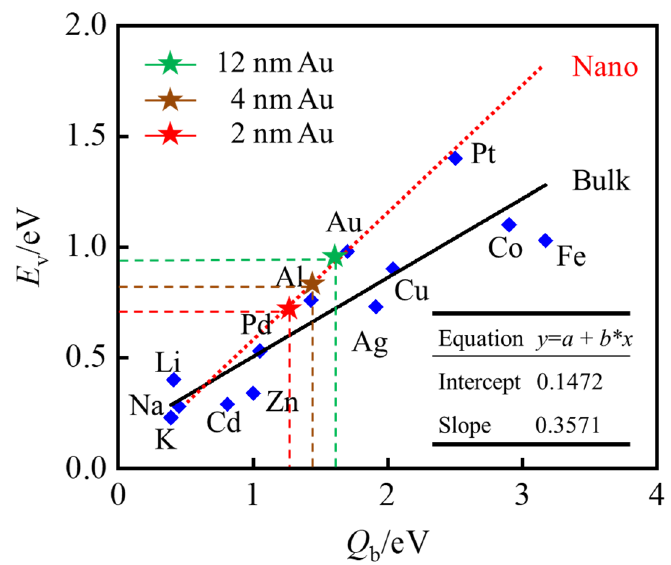
Figure 7. Relationship between vacancy formation energy and diffusion activation energy. (The black line in the figure is the trend line fitted to the bulk material, the red dashed line is the trend line fitted to the calculated values of Au nanoparticles, and detailed data can be found in the Supplementary Materials Table S16.)